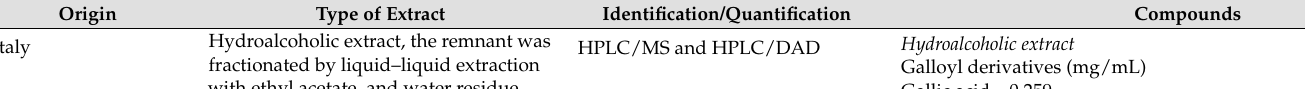
Table 3. Phenols, flavonoids, and acylphloroglucinols in leaf myrtle